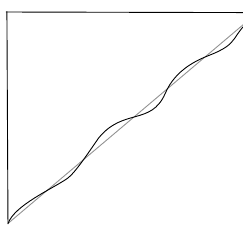
Figure 8 . A shape-deformation of the triangular Young